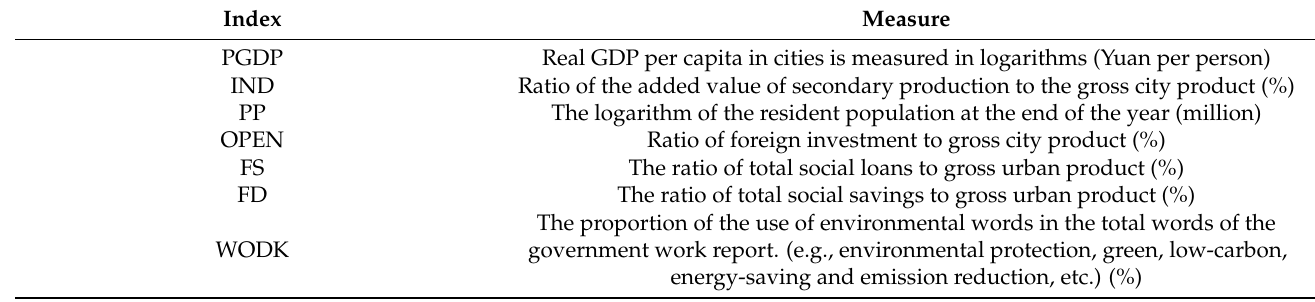
Table 1. Description of